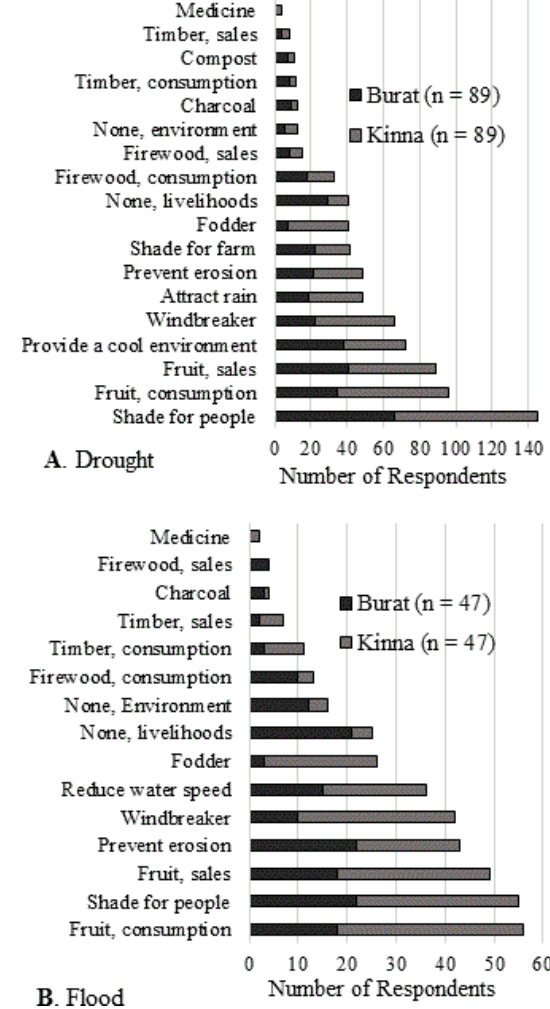
Fig. 4. Livelihood and environmental benefits of trees during drought (A) and flood (B). Data are from household